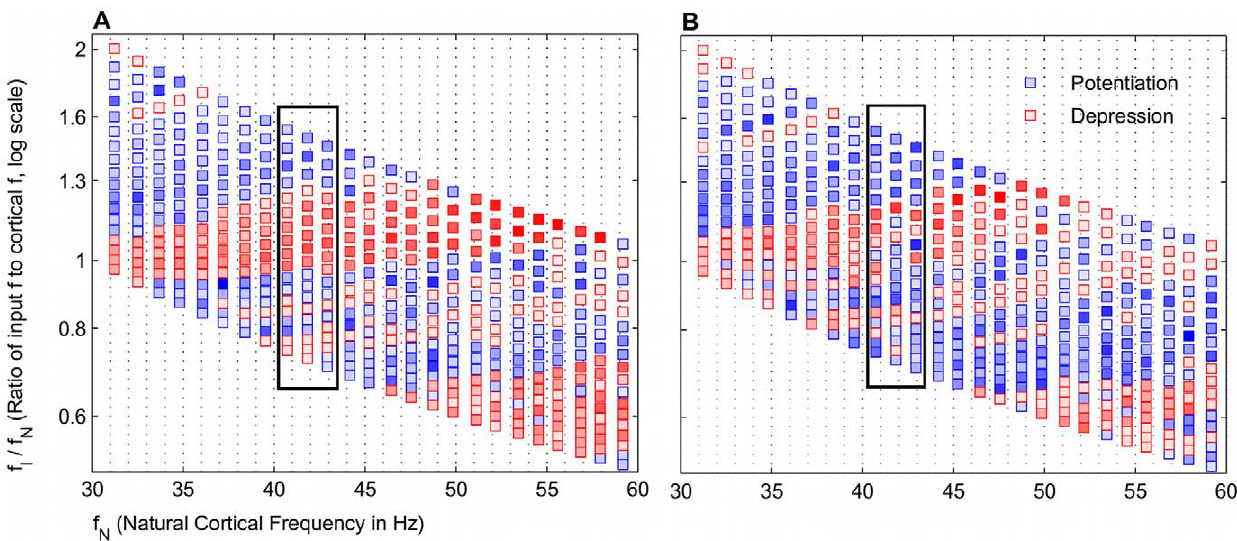
Figure 12. A larger decay constant for glutamate tttt glu eliminates some bands in frequency map. Conductances are averaged around window w ~ 100 ms to calculate potentiation and depression. These simulations were run with noisy inputs (See Methods). (A) Frequency map for t glu ~ 1 : 2 ms . Standard bands of potentiation and depression were observed. (B) Frequency map for t glu ~ 5 ms . Several points of potentiation and depression were altered, and some f N did not have broad bands of potentiation interspersed with depression, highlighted in boxed regions.